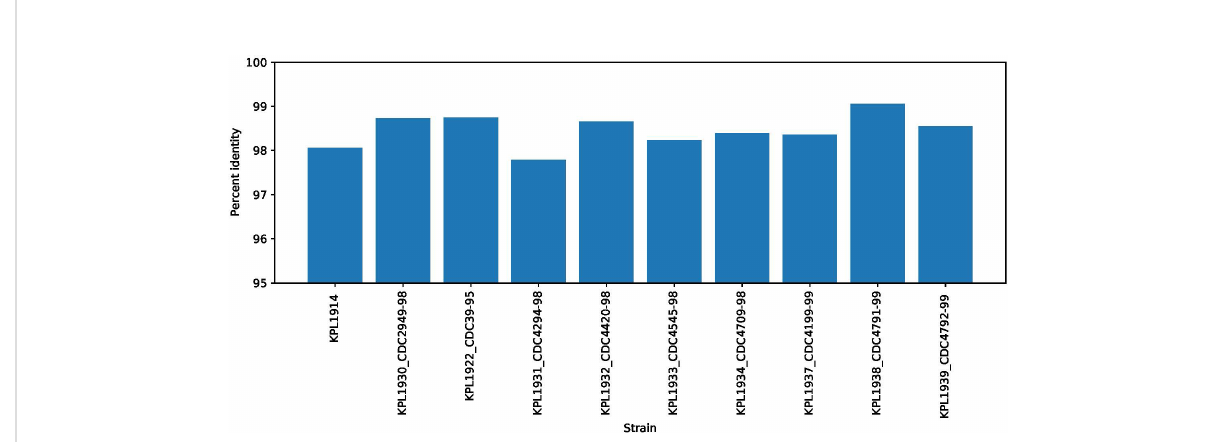
FIGURE 12 The fi gure represents the similarity between D. pigrum strain VPs-KB5 applied in this study and strains surveyed by Brugger et al. assessed by BLAST. As the percent identity shows, our study ’ s strain has high similarity to the strains studied by Brugger et al,